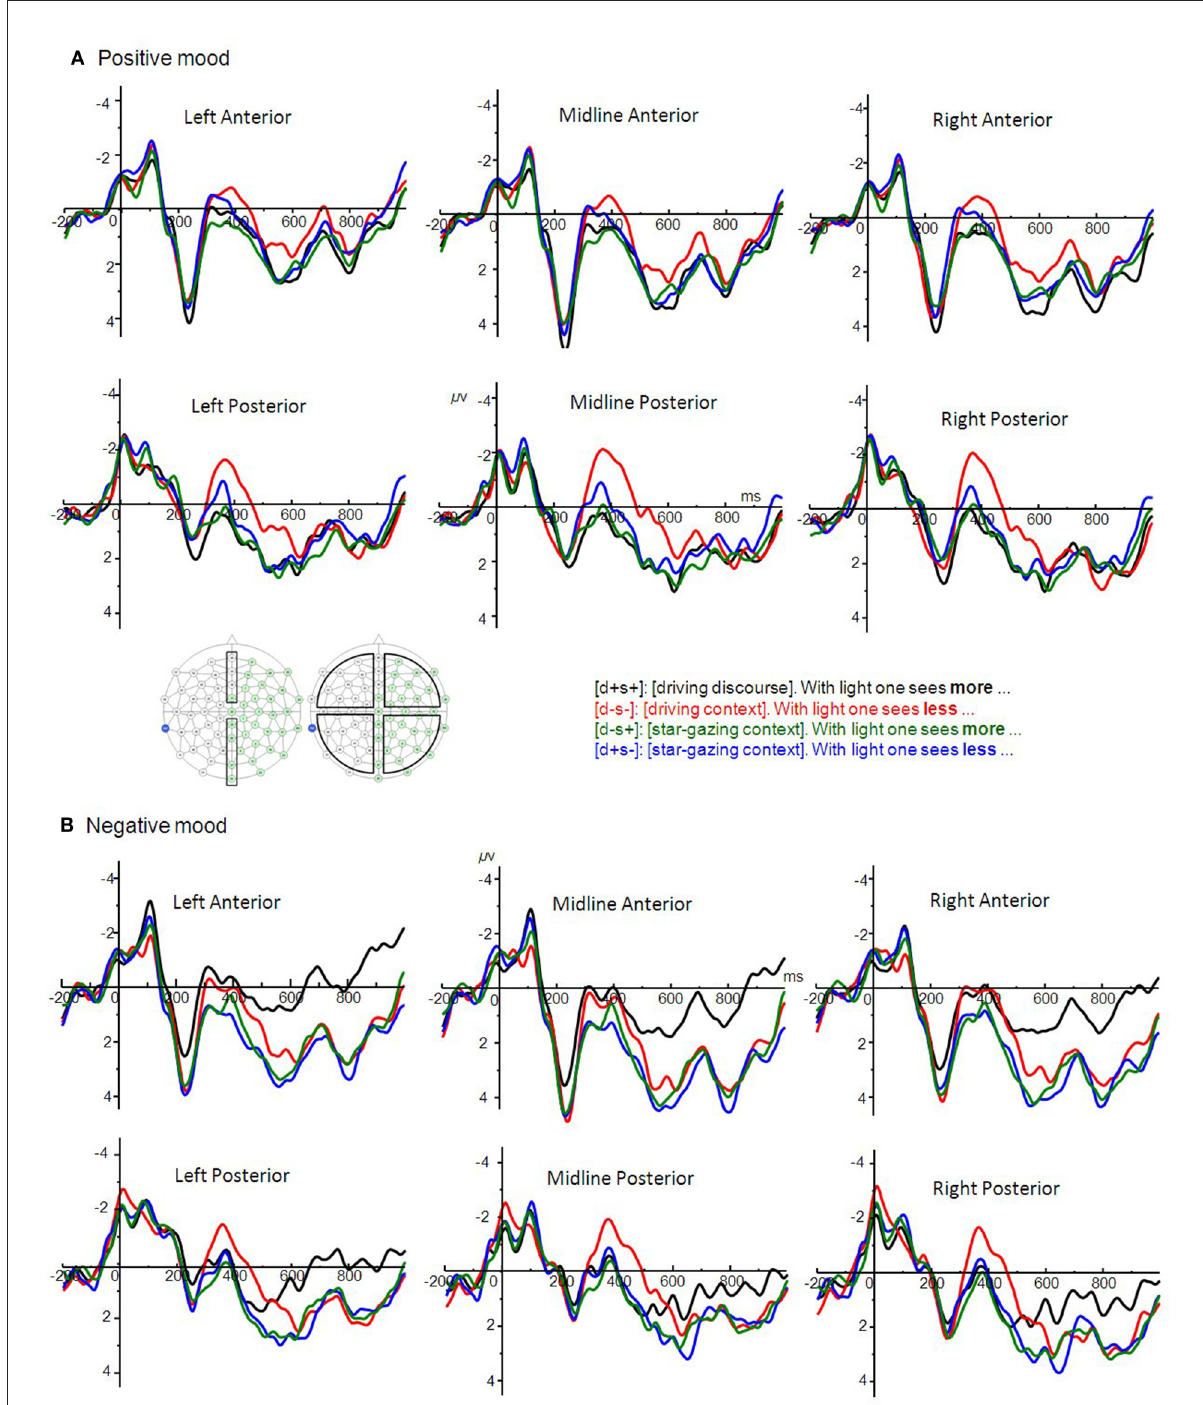
FIGURE3 Grand ERP averages for the critical words supported by the discourse context and the sentence context ([d + s + ], black line), unsupported by the discourse context and unsupported by the sentence context ([d-s-], red line), supported by the sentence context but not by the discourse context ([d-s + ], green line), and supported by the discourse context but not by sentence context ([d + s-], blue line) in grouped channels in the 2 (anterior, posterior) x 3 (left, middle, right) regions, in the positive mood state (A) and the negative mood state (B) . Negative voltage is